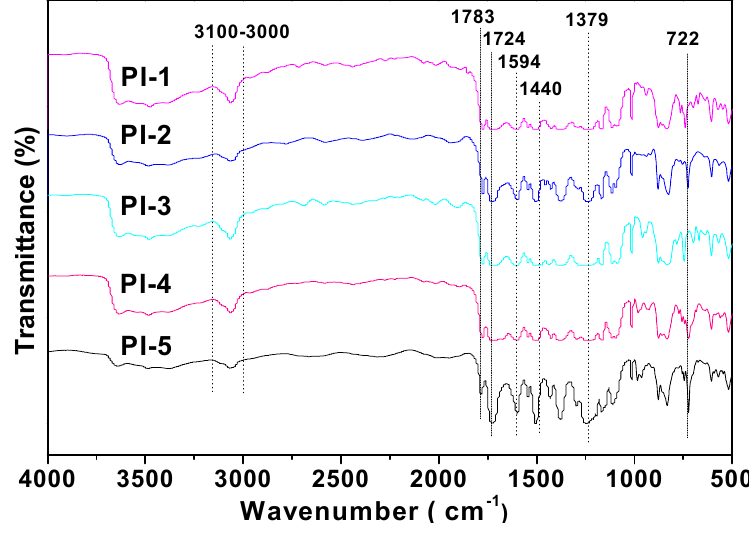
Figure 2. Fourier Transform Infrared (FT-IR) spectra of polyimide filmes.